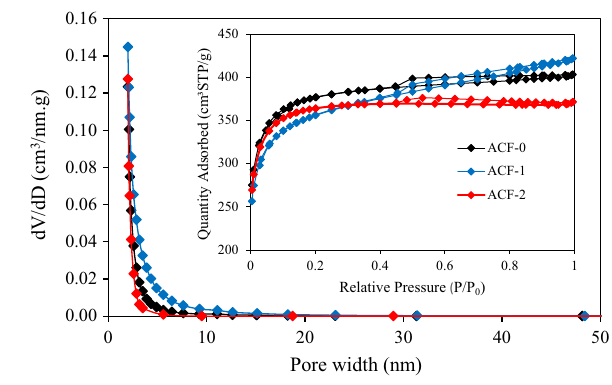
Fig. 1 Pore size distributions of ACF-0, ACF-1 and ACF-2. The inset shows the variation in the mesoporous and microporous character of nitrogen adsorption/desorption